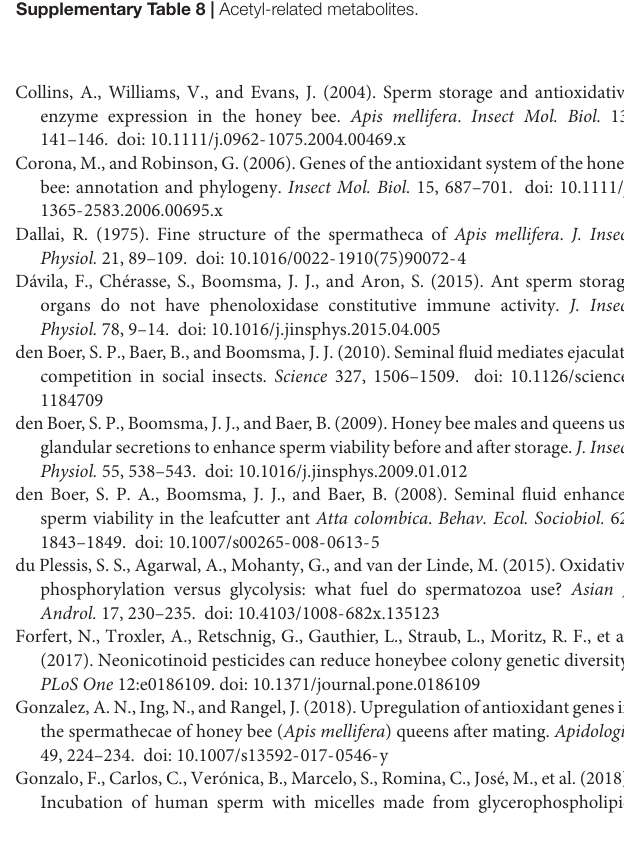
Supplementary Table 5 | Metabolic pathway enrichment analysis. Supplementary Table 6 | Metabolites in the class fatty acids. Supplementary Table 7 | Essential amino acid metabolites. Supplementary Table 8 | Acetyl-related